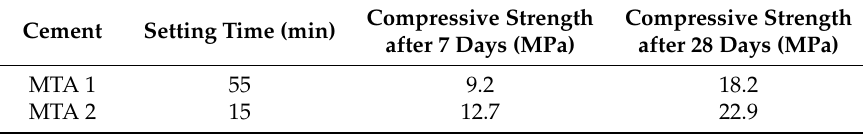
Table 3. Setting time and compressive strengths of MTA